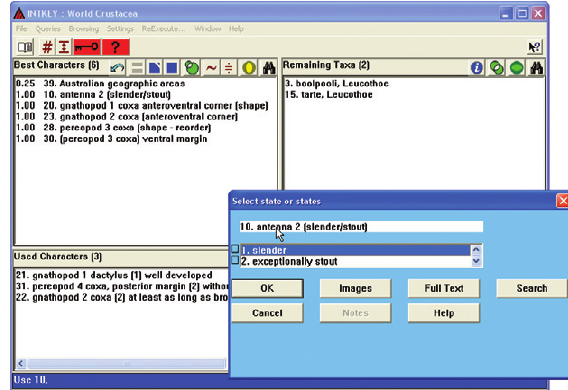
Figure 76. Selecting character